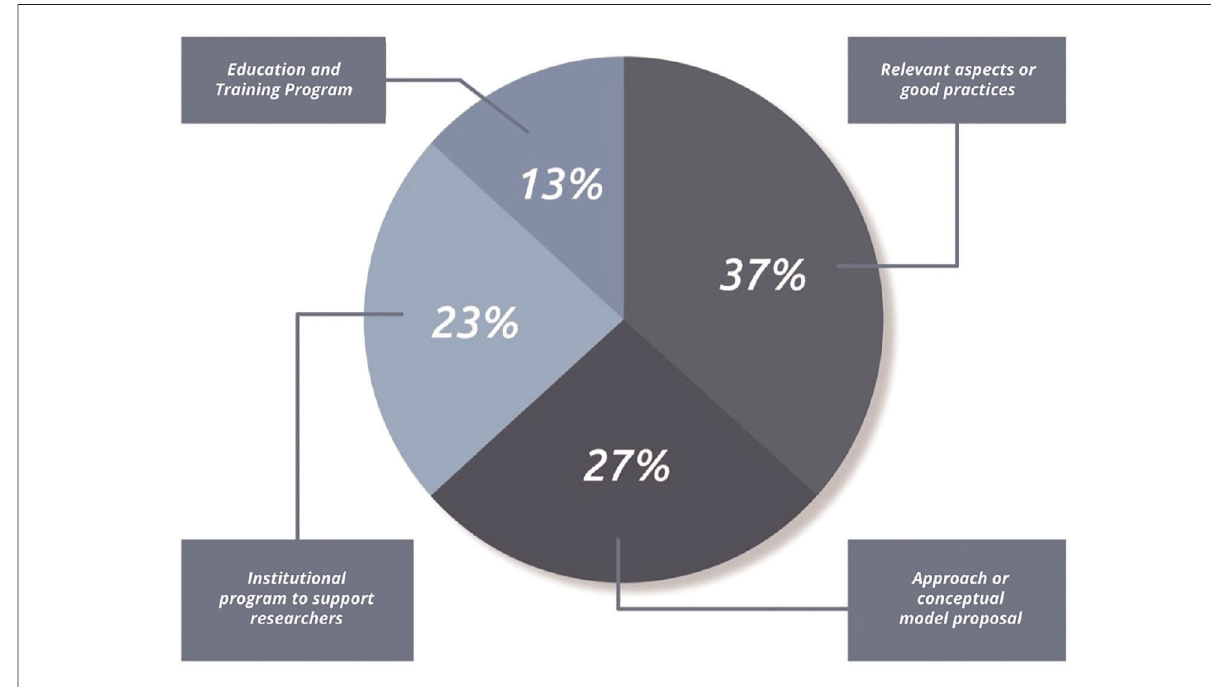
FIGURE 2 Classi fi cation of the included articles, by object of study.